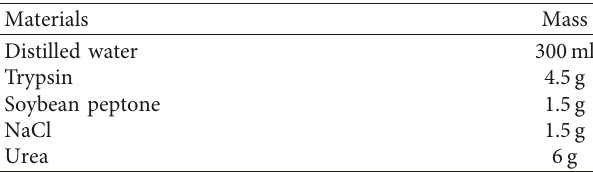
Figure 2: Microbes provide nucleation sites for the deposition of Table 1: Mass of each component in nutrient solution of 300mL.